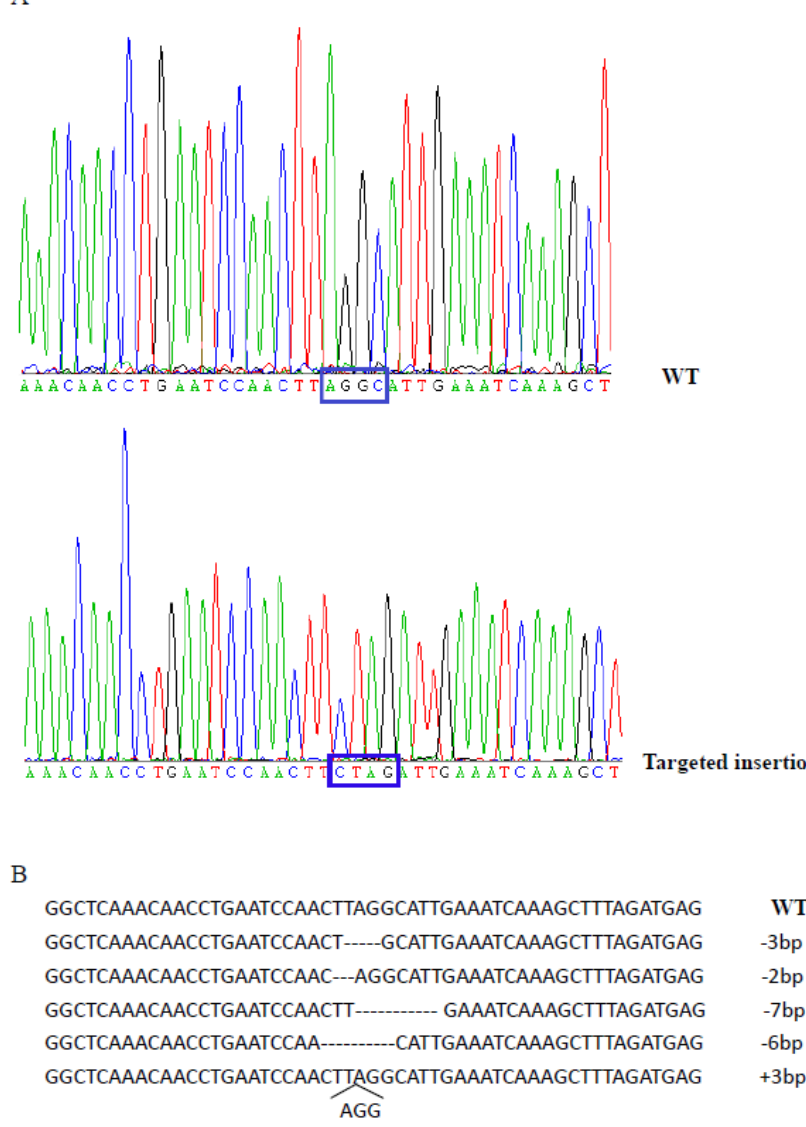
Figure 2. Sequence analysis of MSTN-modified cells. (A) MSTN sequence of cell colonies derived from TALEN/ssODNs-treated cells. WT, wild-type. Targeted insertion in #9 colonies: a stop codon (TAG) was targeted insertion into MSTN locus. (B) MSTN sequence of cell colonies derived from TALEN-treated cells. MSTN, myostatin; TALEN, transcription activator-like effector